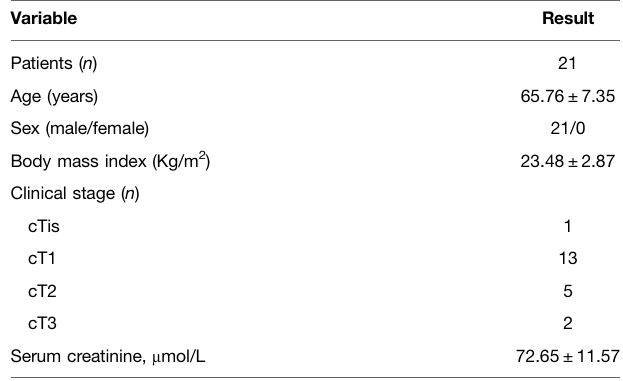
TABLE 1 | Preoperative